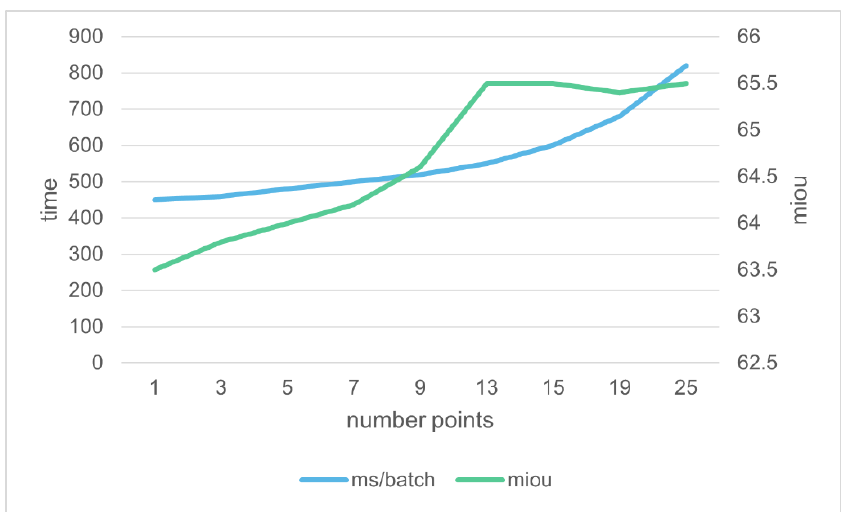
Figure 14. mIOU and time of semantic segmentation for different numbers of kernel points.